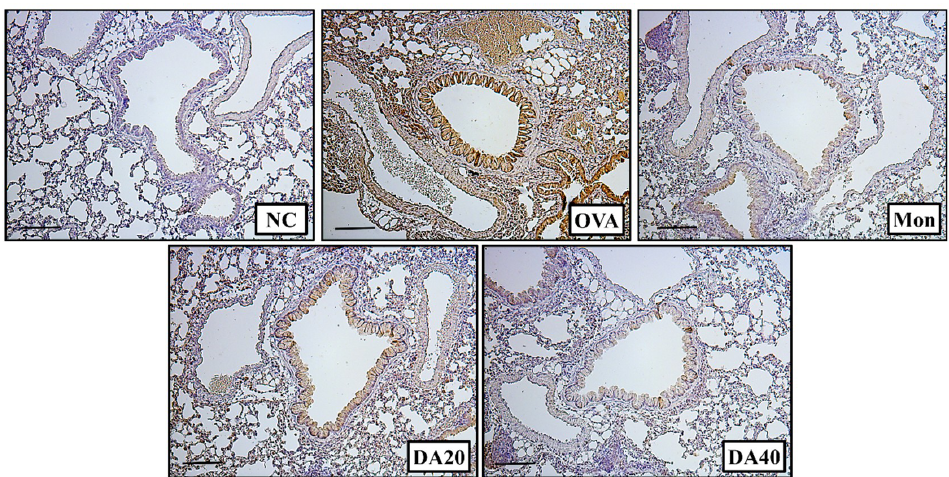
Figure 7. DA decreased iNOS expression in the lung tissue of OVA-induced asthma model. DA-treated mice exhibited a reduction in iNOS expression in the lung tissue compared with OVA-induced asthma model. NC: normal controls, PBS treatment and inhalation; OVA: PBS treatment with OVA sensitization and inhalation; Mon: montelukast-treated mice (10 mg / kg, oral gavage) with OVA sensitization and inhalation; DA20 and 40: Dipsacus asperoides C. Y. Cheng et T. M. Ai-treated mice (20 and 40 mg / kg, respectively, oral gavage) with OVA sensitization and inhalation. Scale bar = 50 µm.